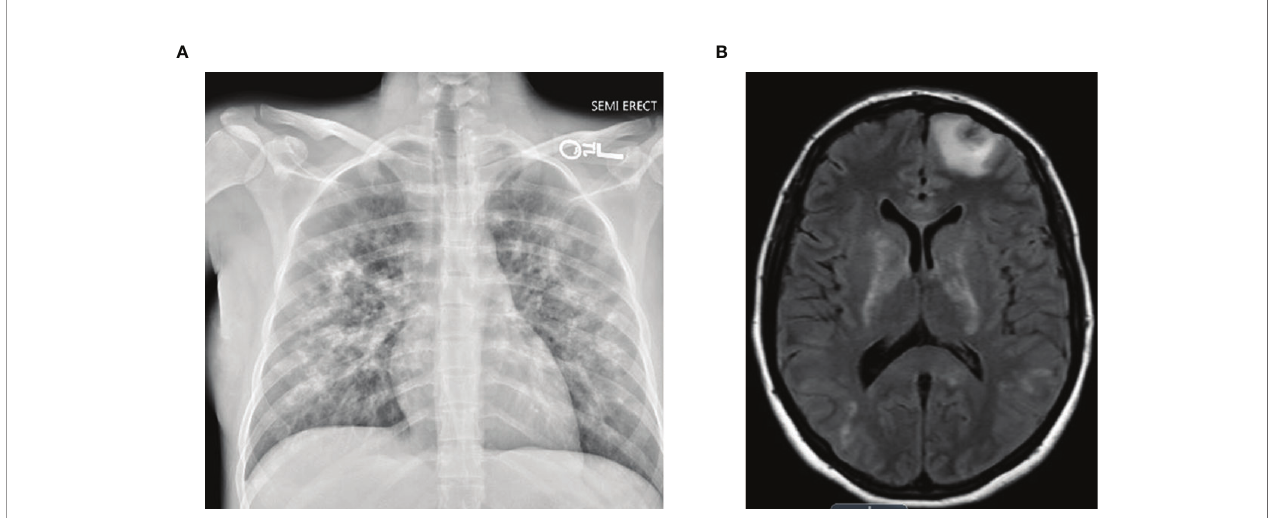
FIGURE 1 | (A) Chest X-ray revealing diffuse interstitial and airspace opacities. (B) Brain MRI revealing extensive fl uid-attenuated inversion recovery (FLAIR) signal abnormalities throughout supratentorial